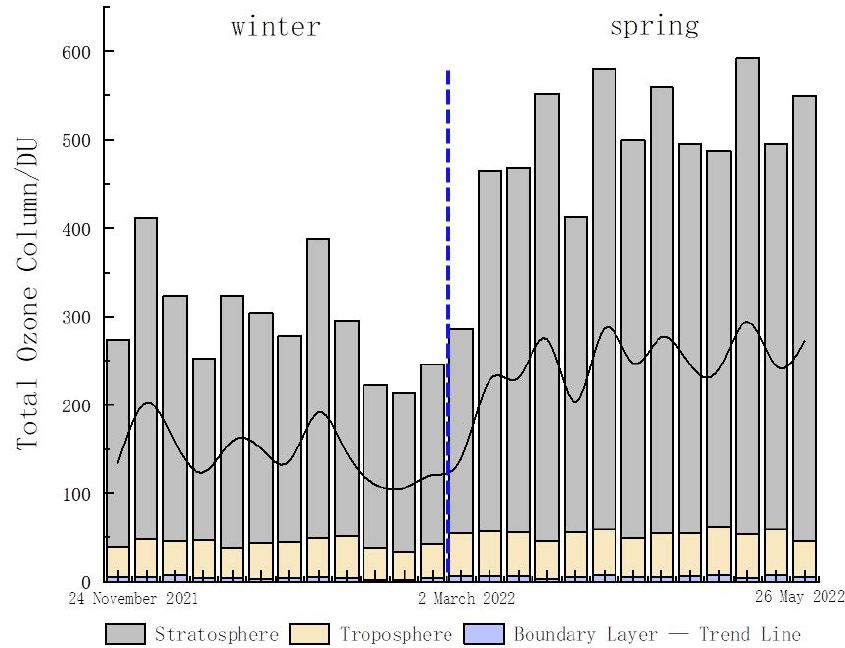
Figure 6. The TOC over the stratosphere (grey bar), the troposphere (yellow bar), and boundary layer (blue bar), as well as the trend line (black line), derived from each ozonesonde observation from November 2021 to May 2022. The vertical blue dash line means to distinguish winter from spring. (The boundary layer: 0–1.5 km; troposphere (including boundary layer): 0—tropopause height (km); stratosphere: tropopause height (km)—balloon burst height (km)).